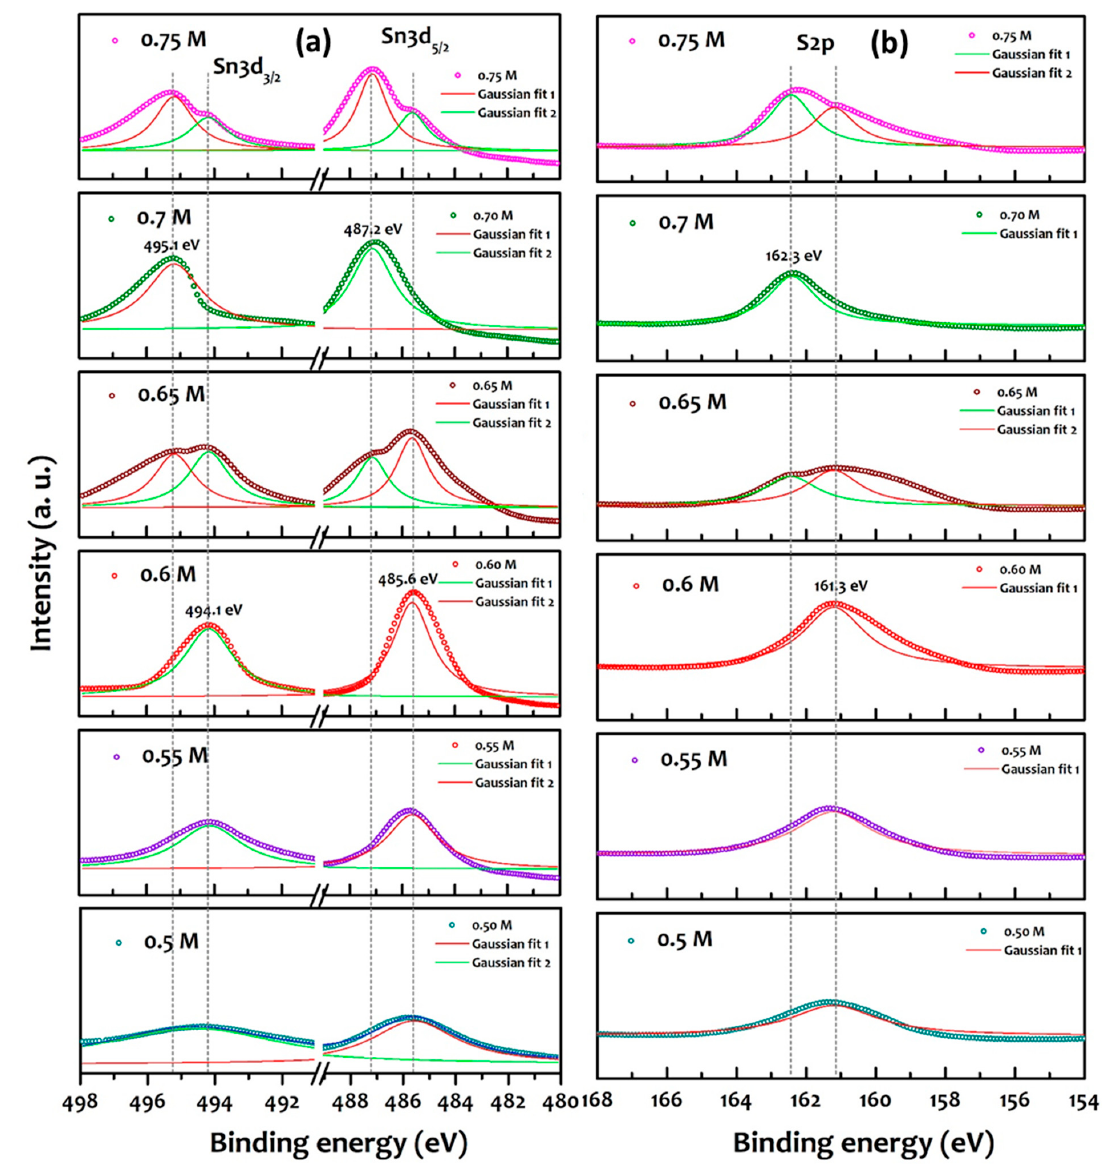
Figure 3. High-resolution X-ray photoelectron spectrometer (XPS) scan of ( a ) Sn 3d and ( b ) S 2p Figure 3. High ‐ resolution X ‐ ray photoelectron spectrometer (XPS) scan of ( a ) Sn 3d and ( b ) S 2p core 112 levels. 113 core